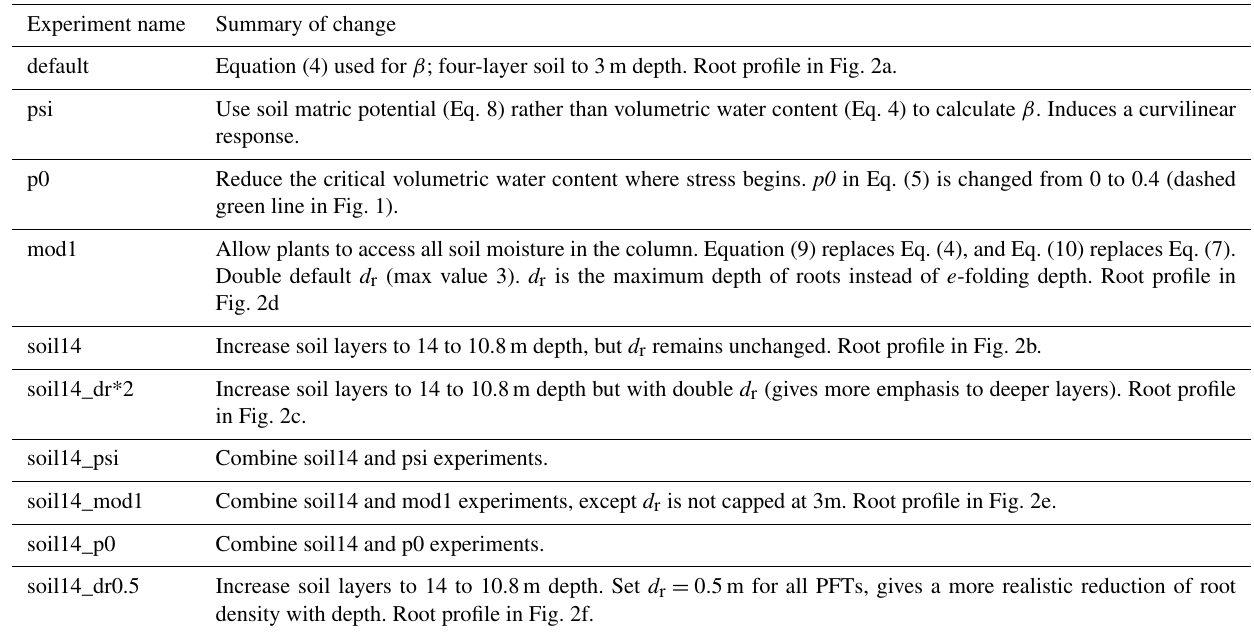
Table 1. Summary of the 10 JULES model experiments related to the treatment of soil moisture